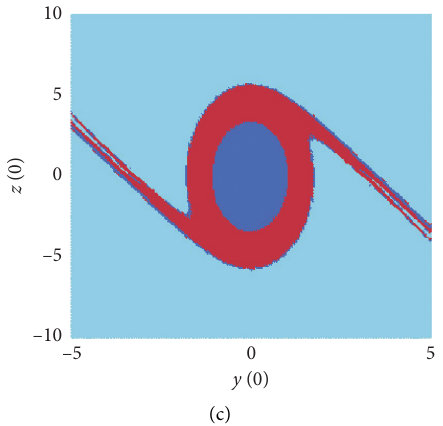
Figure 2: Attractor basin of system (1): (a) initial value x - y plane; (b) initial value x - z plane; (c) initial value y - z plane.